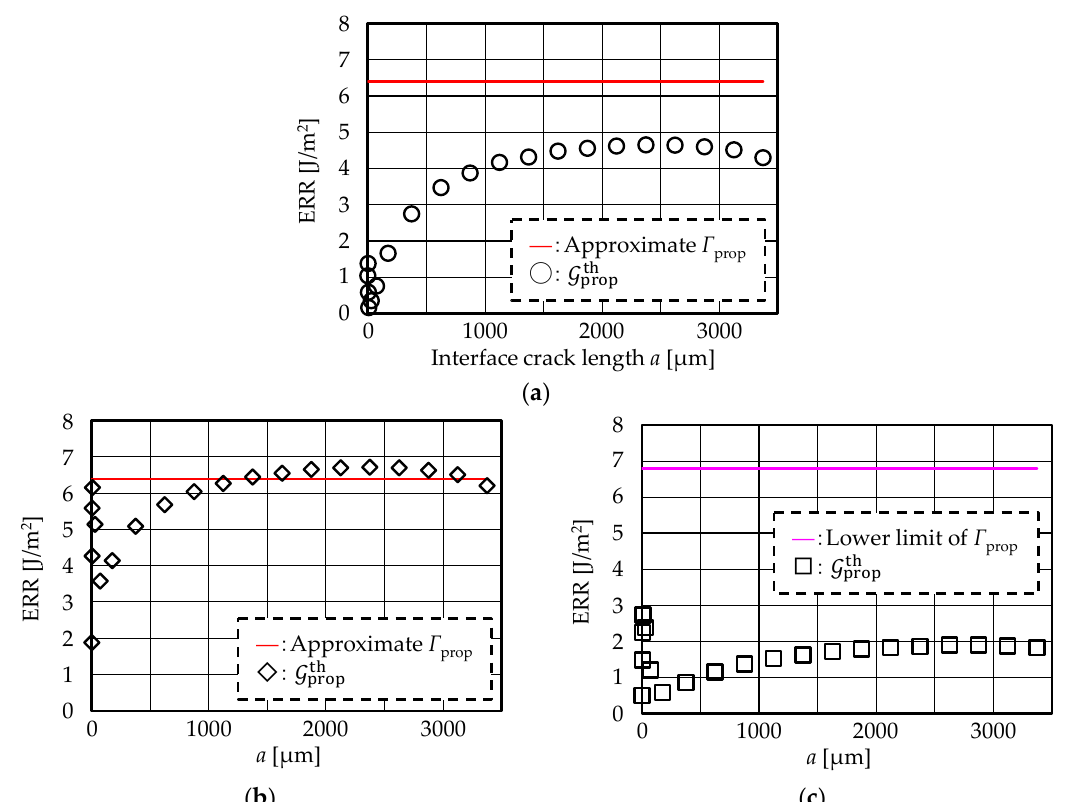
Figure 13. Comparison between ERR for crack propagation due to thermal stress and fracture